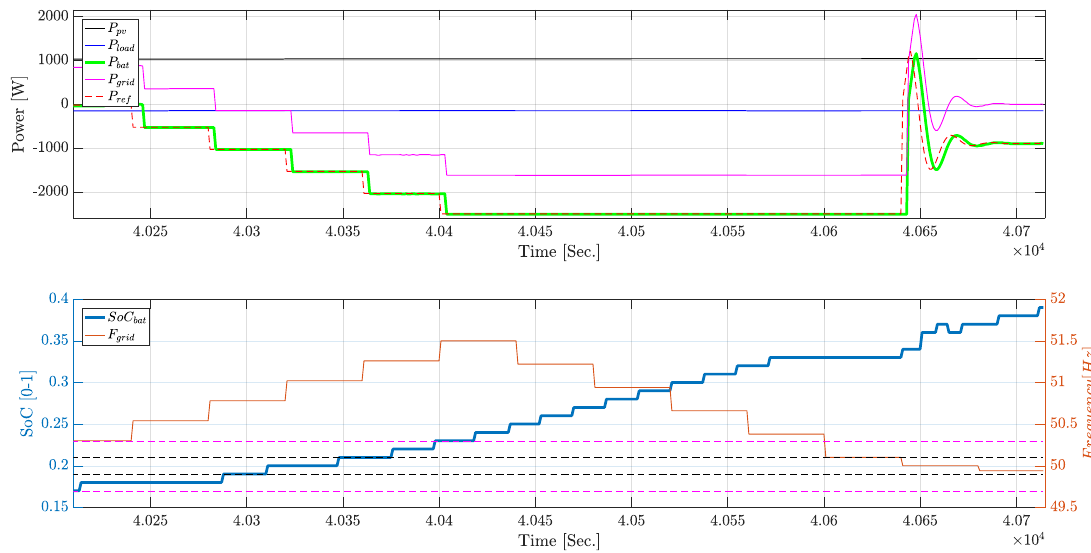
Figure 17. Real measurements ( P bat , SoC bat ) and simulated values to perform FW and